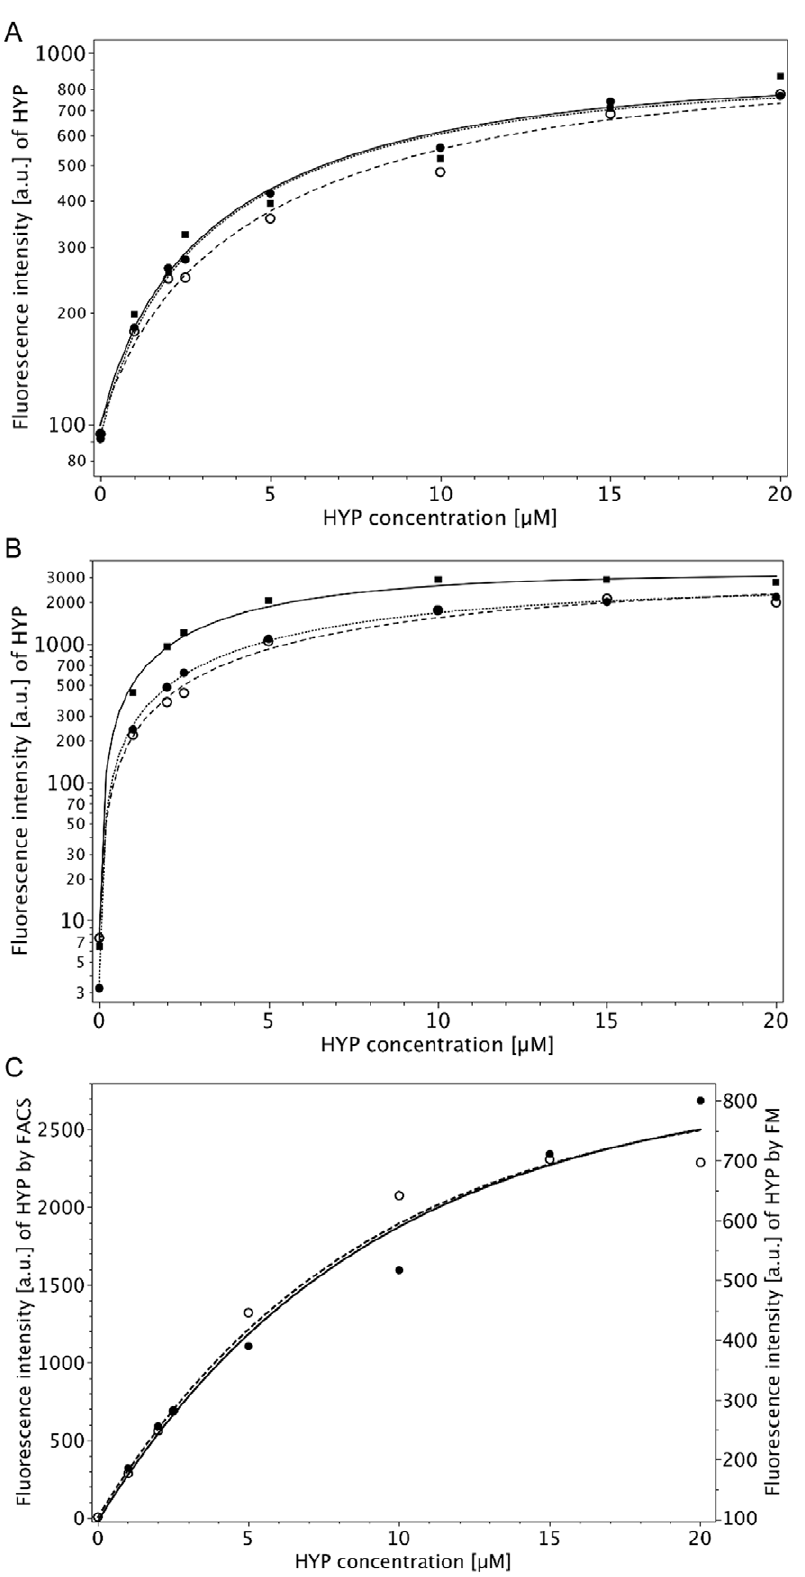
Figure 3. Concentration-dependent intracellular HYP accumulation in D283 Med cells determined by fluorescence microscopy (FM) (A) and FACS analysis (B) after 2h-incubation at 37 6 C (three independent experiments). Each symbol is the mean value of 20 cells (FM) or 200.000 cells (FACS). Comparison of FM (continuous line, right ordinate) and FACS (dashed line, left ordinate) data. ( C ) Curves are based on the means of the values in A and B. Note that the curves are nearly identical, taking into account the difference in autofluorescence. The means for b , a , and A